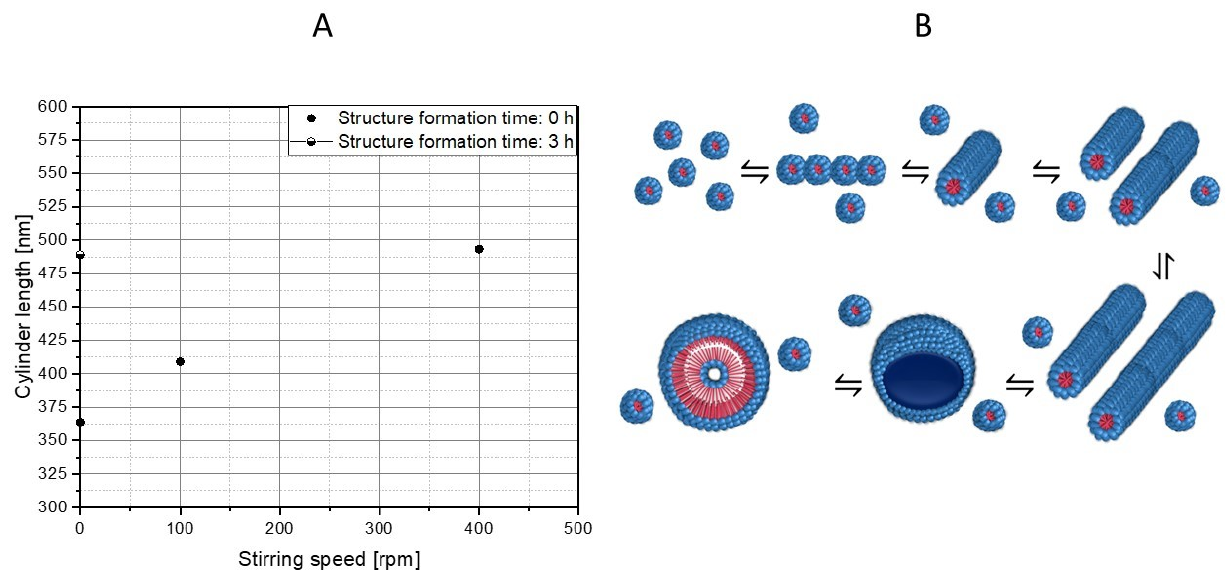
Figure 10. Influence of stirring speed and structure formation time on the lengths of the cylinders ( A ). Derived structure formation mechanism, from micelle formation to vesicle emergence ( B ). The hydrophilic part PAA is shown in blue and the hydrophobic part PS of the block copolymer is shown in red.